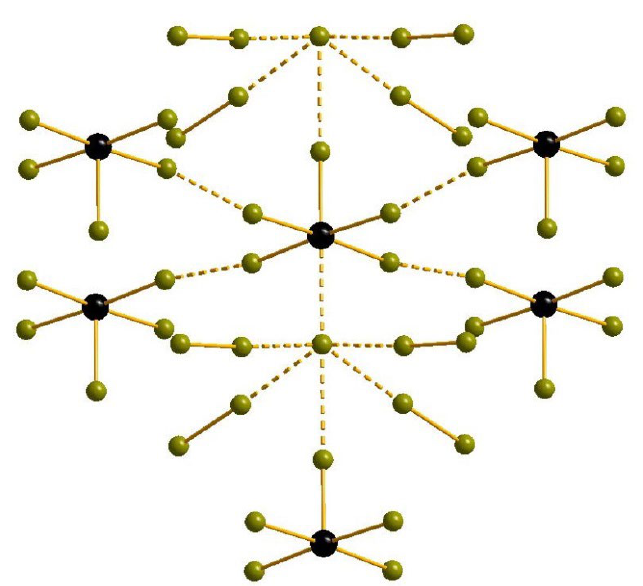
Figure 3. The system of non-covalent interactions in the structure of 3.